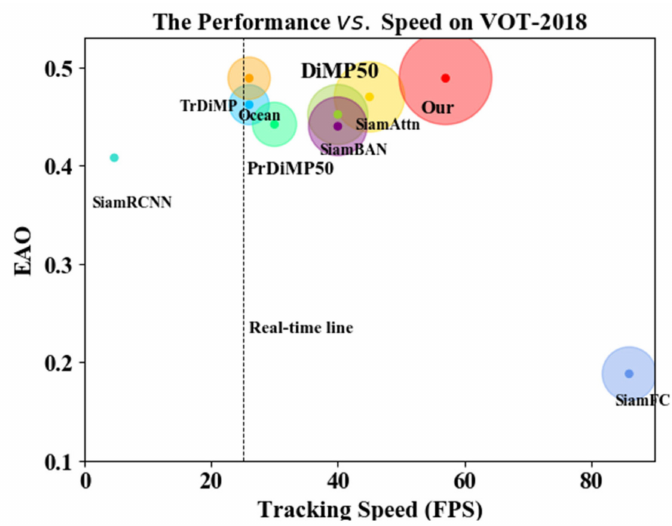
Figure 7. Comparison of the results of the proposed algorithm with other algorithms in terms of running speed and